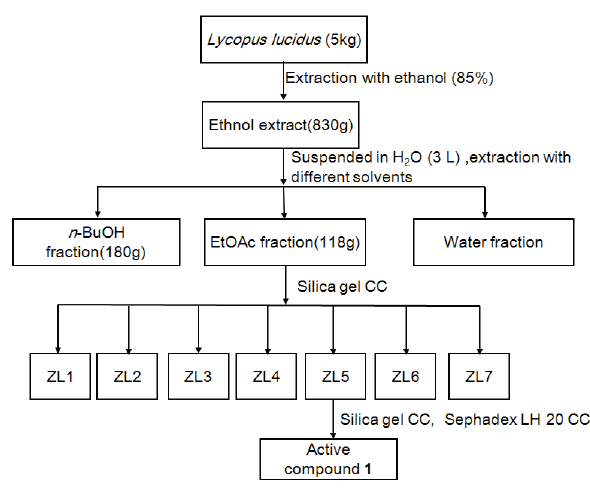
Figure 1: Extraction and isolation process of Lycopus lucidus